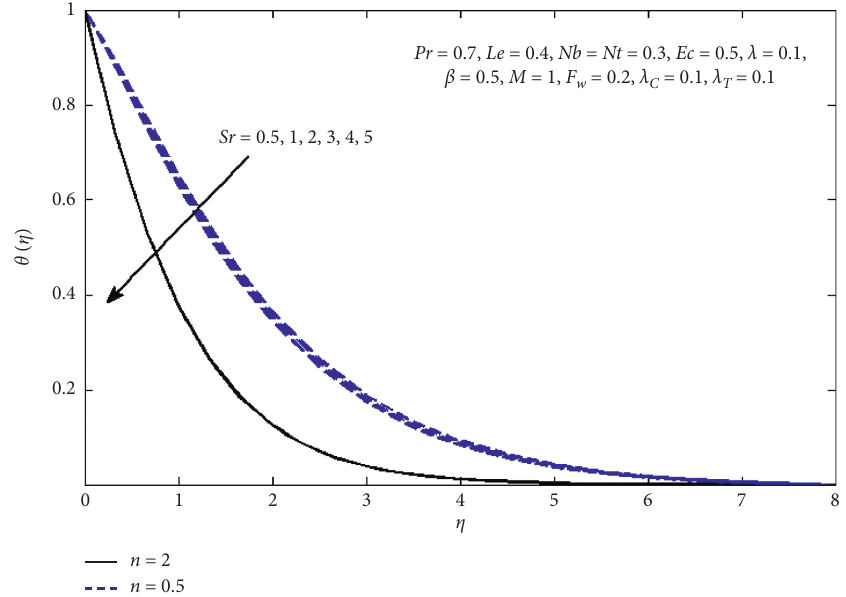
Figure 18: Variation of temperature θ concerning η with various values of Sr ( n � 2 __, n � 0.5